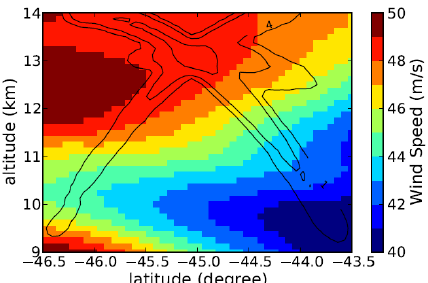
Figure 17. Horizontal wind speeds at 20 ◦ E for 13 September 2012, 14:00UTC. Contour lines indicate the number of tangent points per grid cell. The outer (middle, inner) line marks 2 (4, 16)